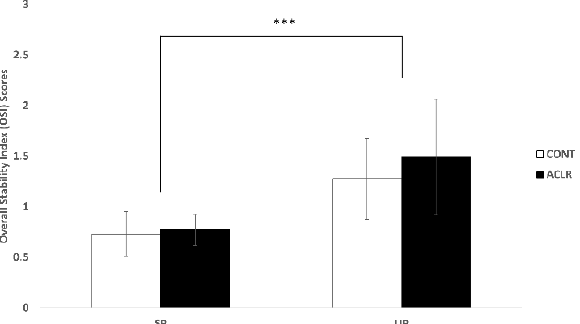
Figure 2 . Postural control results. The unstable condition significantly increased the overall stability index scores when compared to the stable condition (*** p <